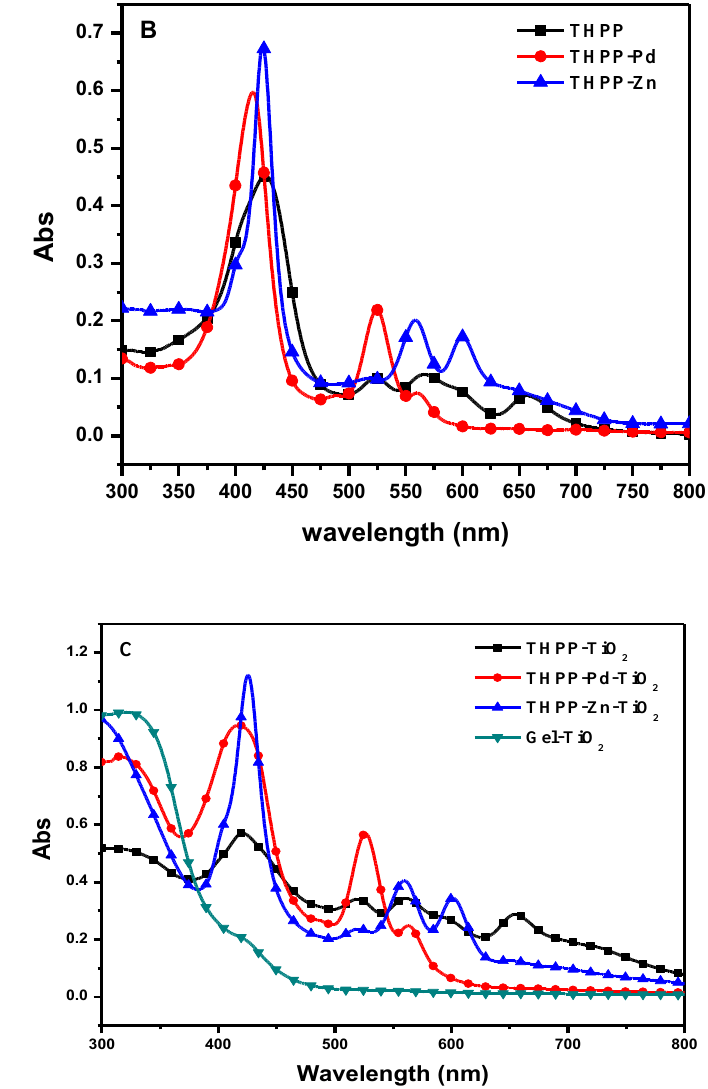
Figure 4. UV-vis absorption spectra of THPP, THPP-Pd, and THPP-Zn ( A ) in DMF solution and ( B ) in solid-state, and ( C ) UV-vis solid-state di ff raction spectra of THPP-TiO 2 , THPP-Pd-TiO 2 , THPP-Zn-TiO 2 and Gel-TiO 2 .